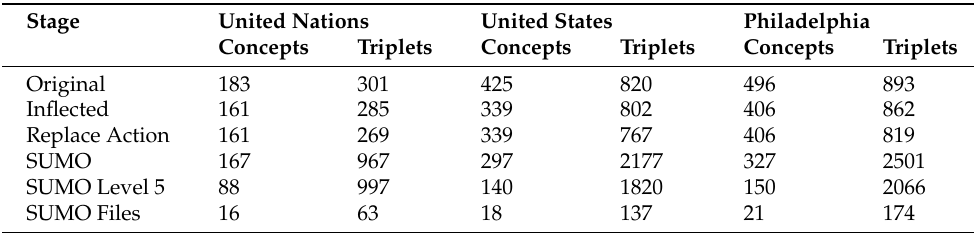
Table 4. Statistics for the triplets extracted from the three documents. For each of the processed document, we calculated (1) the unique count of words/concepts and (2) the unique count of relationships between